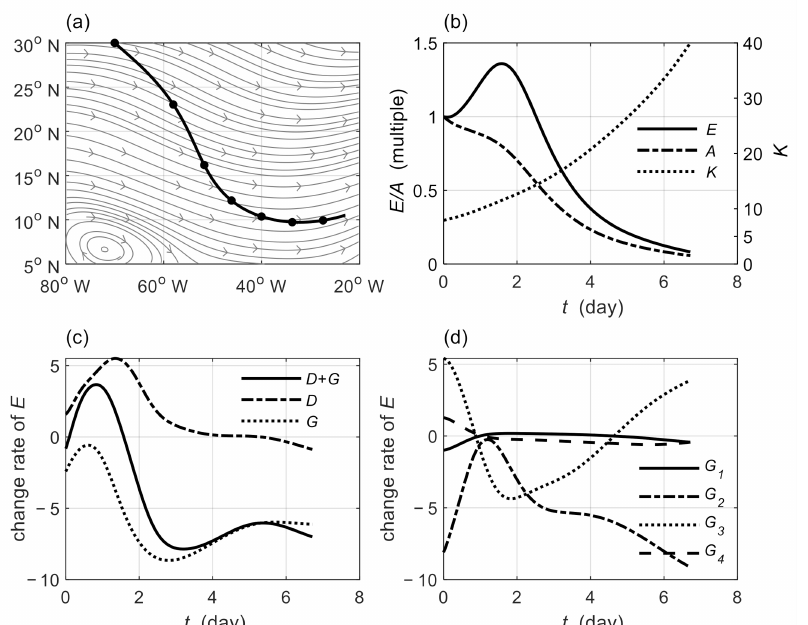
Figure 6. Ray path (solid black dots denoting the one day interval) of the wave (the source is set to 70 ◦ W, 30 ◦ N) with a period T =10 days ( a ). The variations in wave energy ( E , solid line), amplitude ( A , dash-dotted line) and the total wavenumber ( K , dotted line) along the ray ( b ). The variations in the divergence of the group velocity (dash-dotted line, shortened as D ), the energy budget from the basic flow (dotted line, shortened as G ) and the sum of them (change rate of wave energy) along the ray ( c ). The variations in the four components of the energy budget from the basic flow (shortened as G 1 , G 2 , G 3 and G 4 , respectively, and their sum equals G ) along the ray ( d ). D and G ( G 1 , G 2 , G 3 and G 4 ) have been magnified 10 6 times to glory the